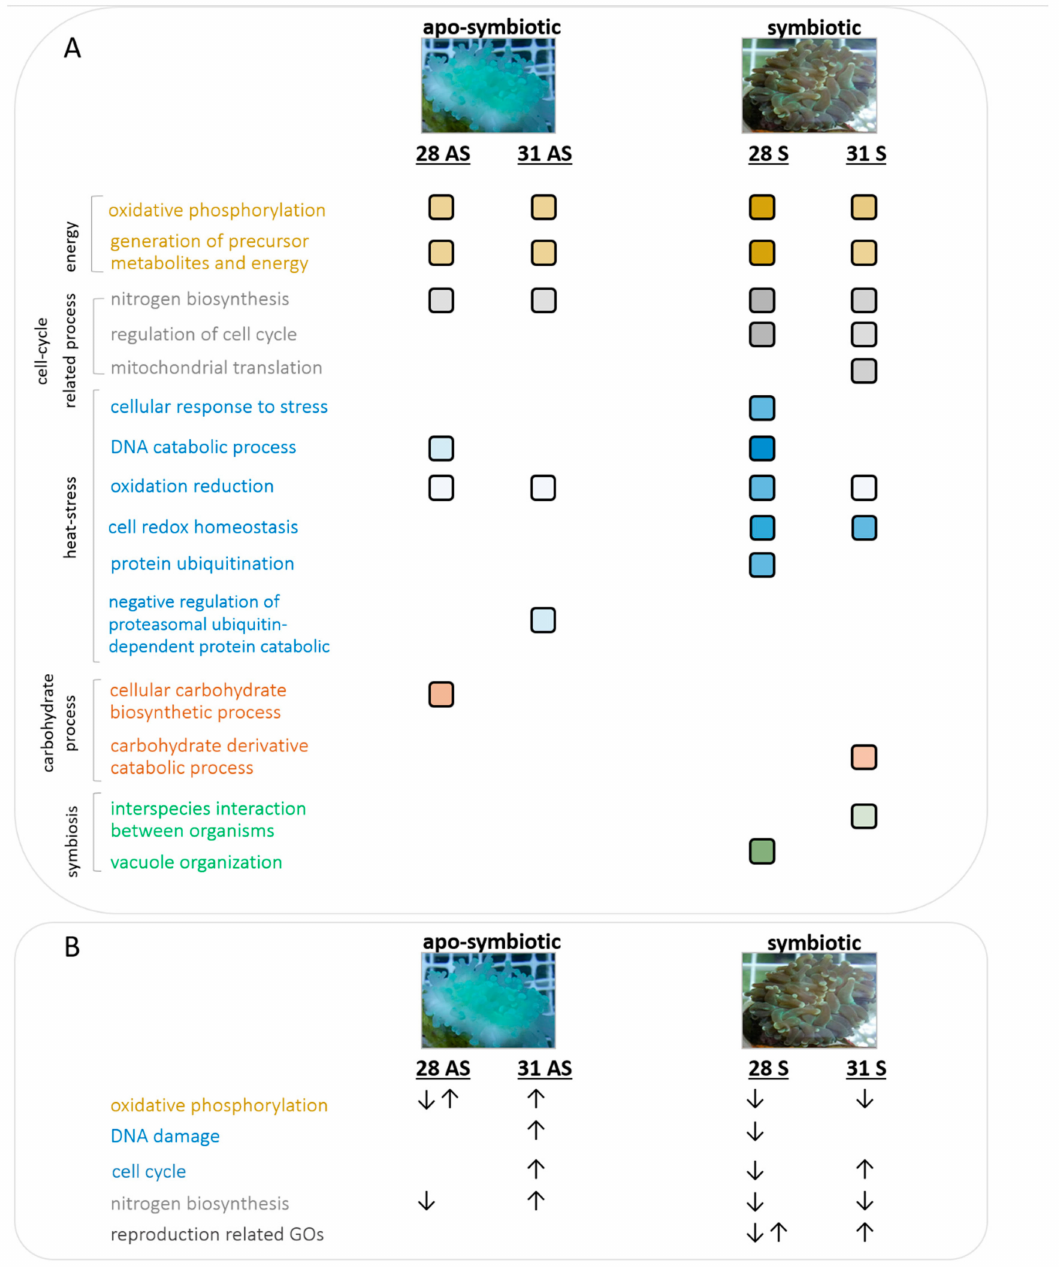
Figure 5. A model summarizing enriched cellular processes and their trends. ( A ) Enriched gene ontologies in symbiotic and apo-symbiotic E. paradivisa throughout the experiment. The color intensity gradient of the squares represents the enrichment of the GO in the treated samples. ( B ) Up- and down-regulated trends of enriched categories in 31 ◦ C-treated apo-symbiotic and 28 ◦ C-treated symbiotic E.